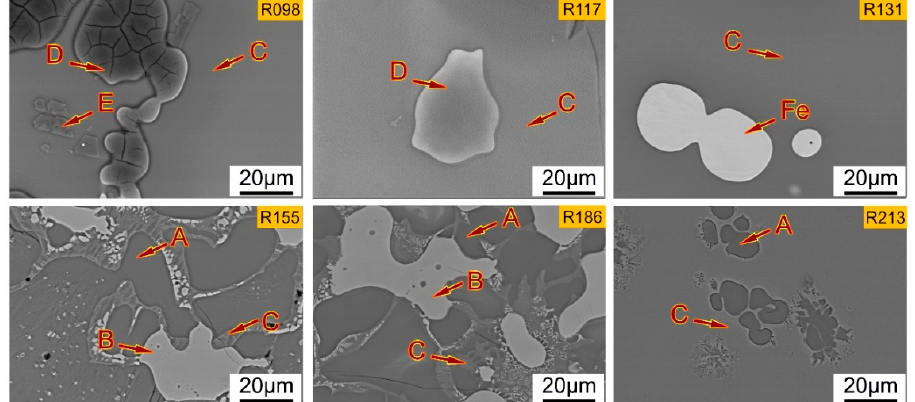
Figure 5. SEM images of dephosphorization slag with magnification of 200 times at different basic- ities.